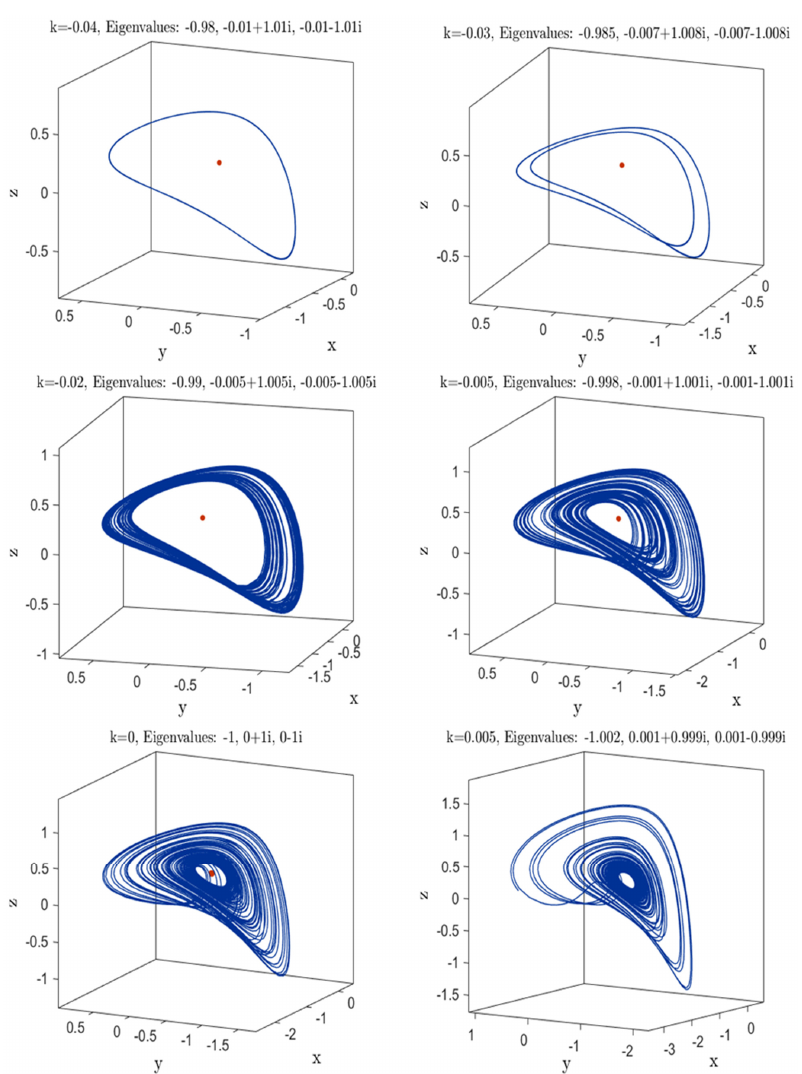
Figure 1. Attractors of System (1) with two different initial conditions. For the initial condition (0, − 1, 0), the system tends to have chaotic or periodic attractors dependent on the parameter k . For non − positive k values, the initial condition ( − 0.01, 0.01, 0.01) tends to the red dot equilibrium. At the top of each panel, the corresponding eigenvalues are presented.